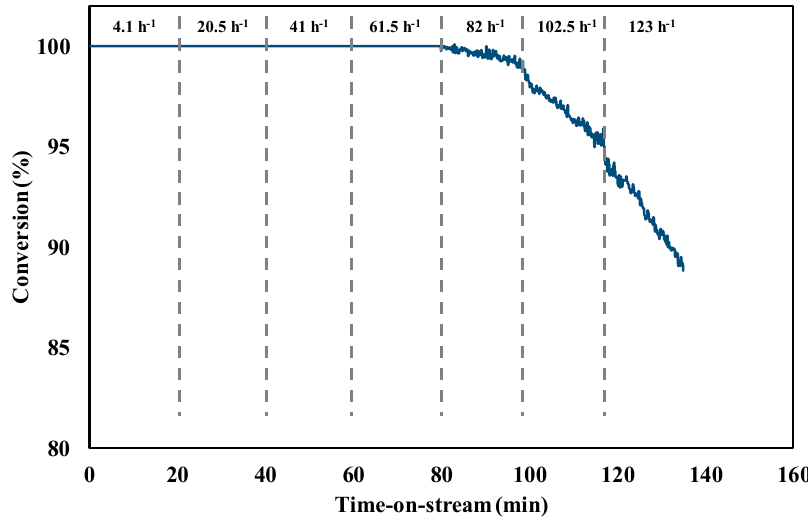
Figure 6. Results of stability test performed over Pt ‐ Ni/CeO 2 /SiO 2 catalyst at 500 °C, H 2 O/EtOH = 4, O 2 /EtOH = 0.5 and WHSV in the interval 4.1–123 h − 1 .